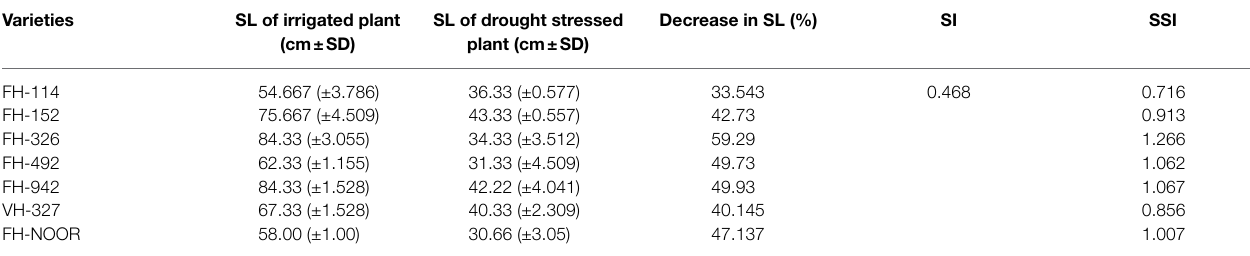
TABLE 1 | Stress susceptibility indices for shoot length (SL) under water limited conditions in comparison with irrigated control. Varieties